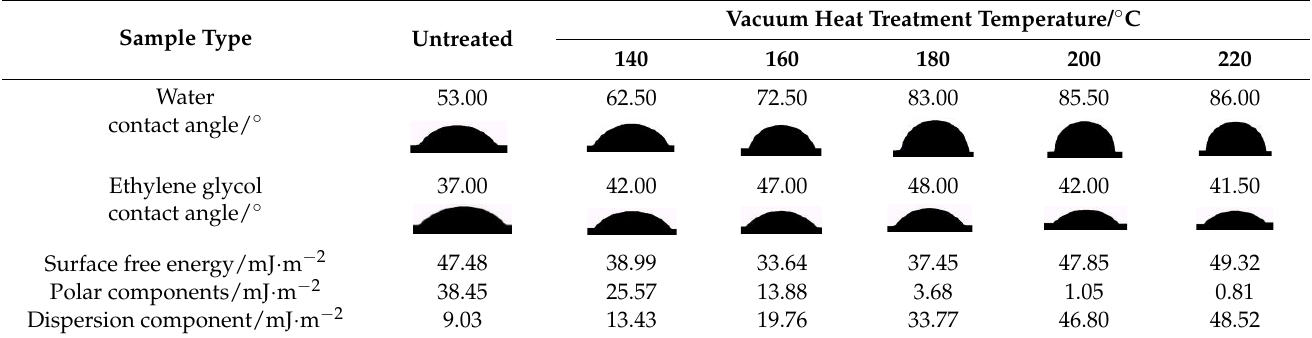
Table 2. Surface contact angle and free energy of moso bamboo fiber.